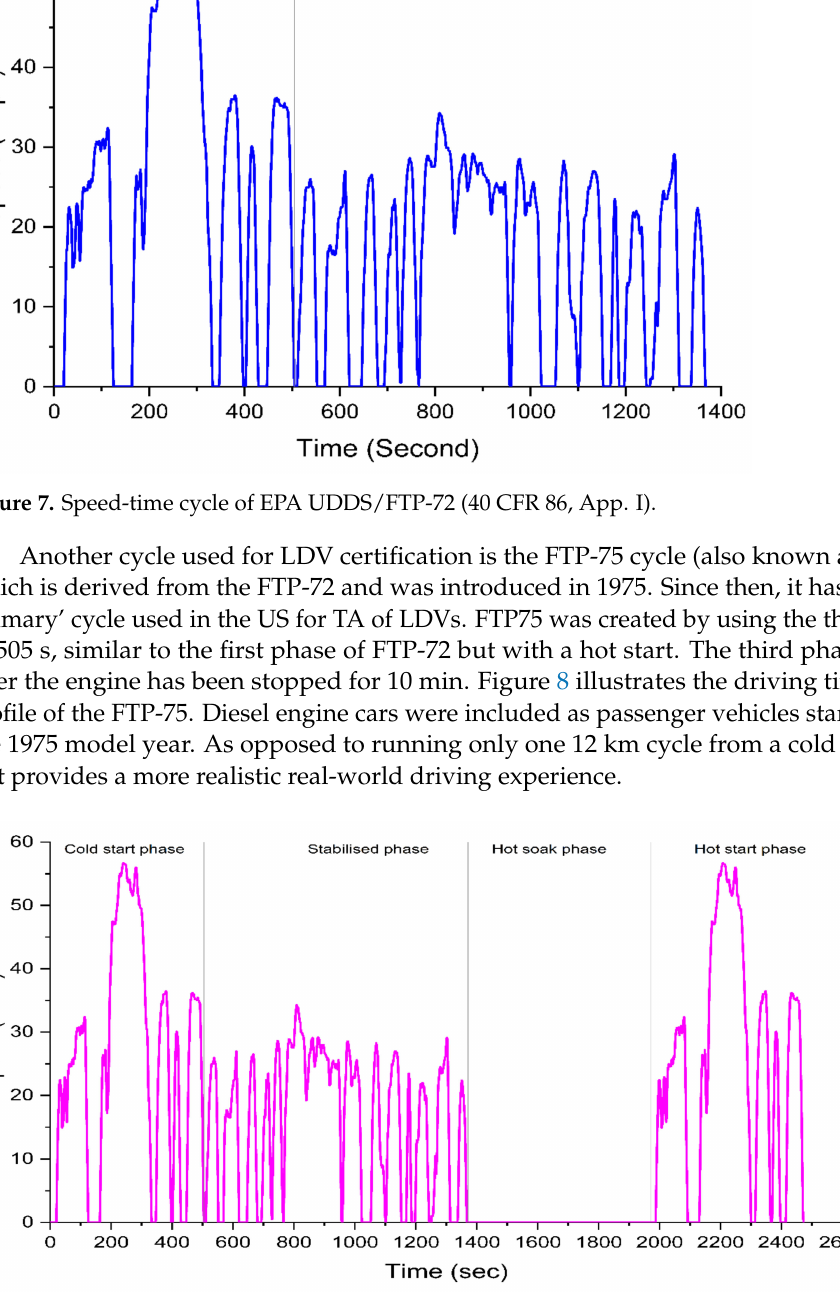
Figure 8. Speed-time cycle of the EPA75/FTP-75 driving